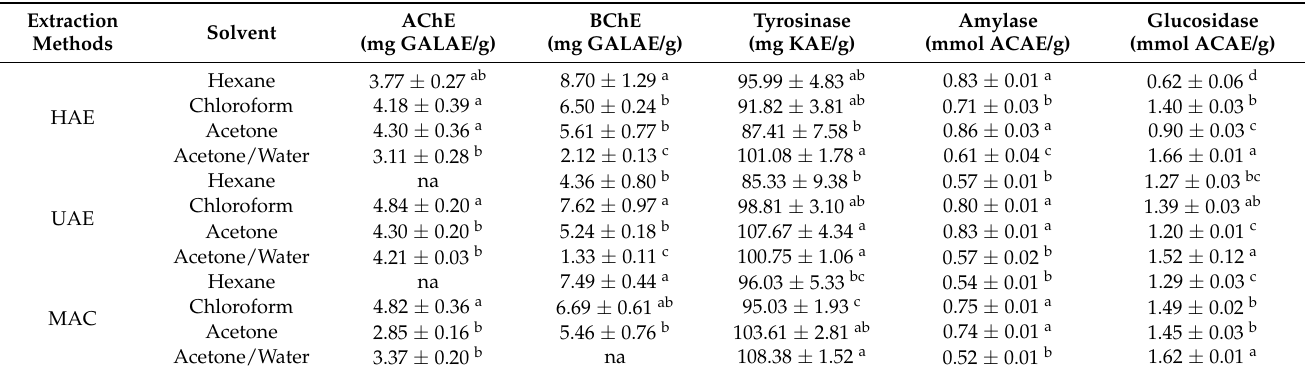
Table 5. Enzyme inhibitory effects of the tested extracts *